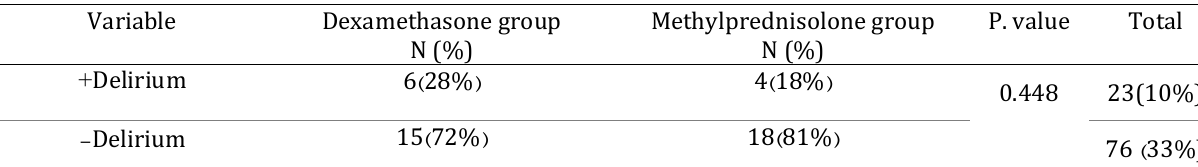
Total P. value Methylprednisolone group